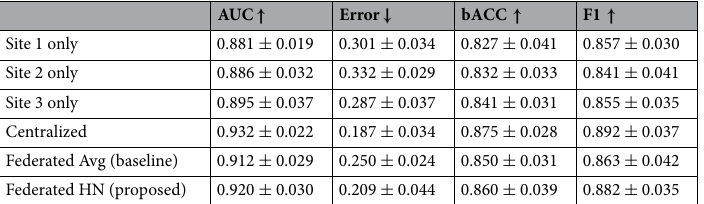
Table 4. Results of classification on TCGA-NSCLC with or without federated